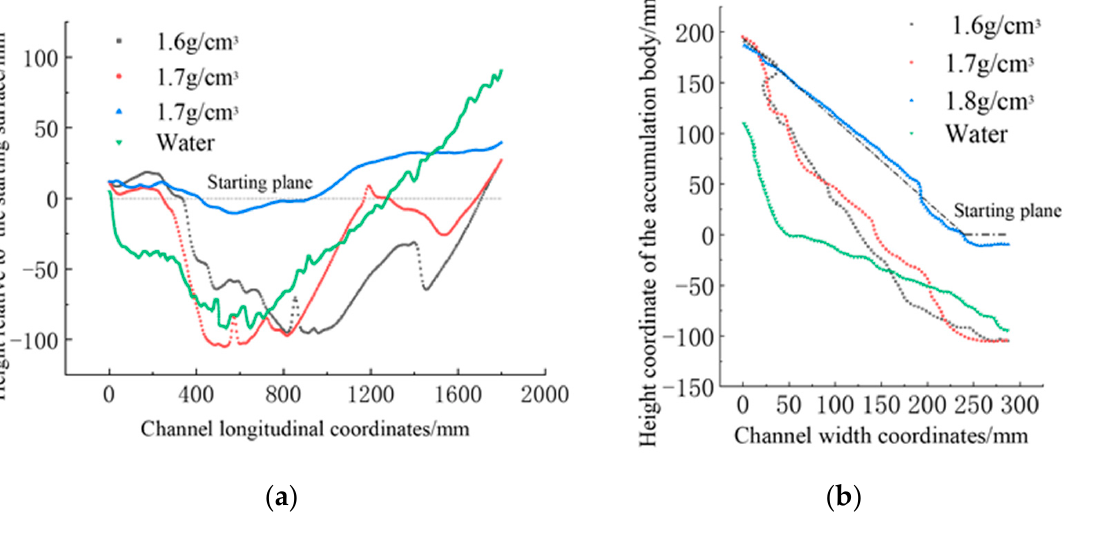
Figure 3. Characteristic cross-section after erosion of debris flow with different capacity. ( a ) Cross- section at maximum erosion depth. ( b ) Cross-section at maximum erosion width.